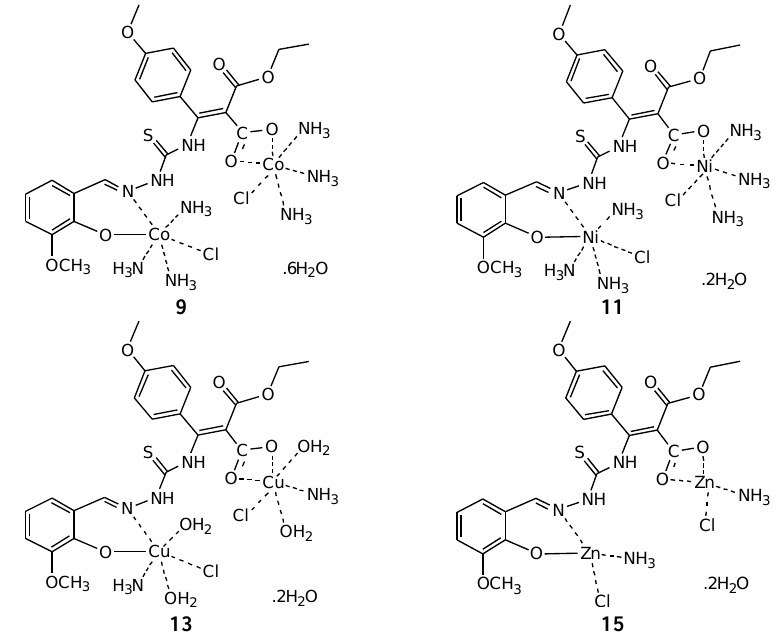
Figure 3. Proposed structures of 1:2 MTSC complexes ( 9 , 11 , 13 , 15 ).